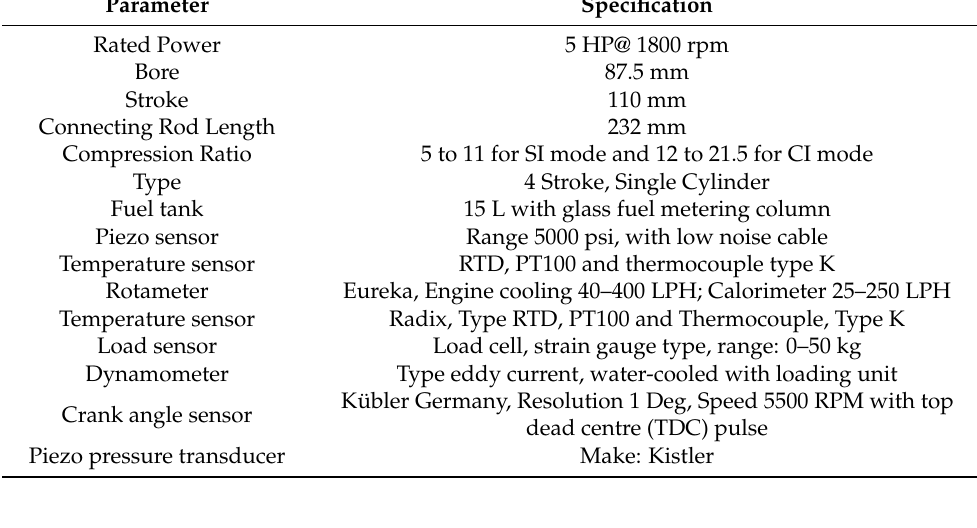
Table 2. Engine specifications.